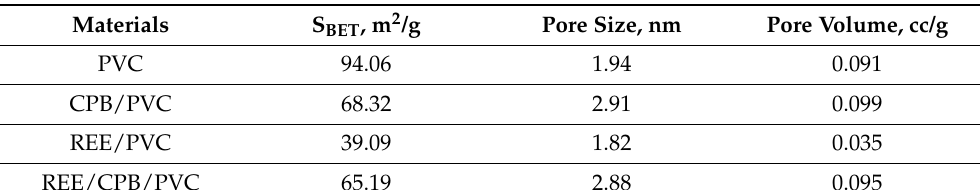
Table 1. Surface area, porosity, and pore volume of PVC and CPB/PVC previously and after rare earth ion sorption.